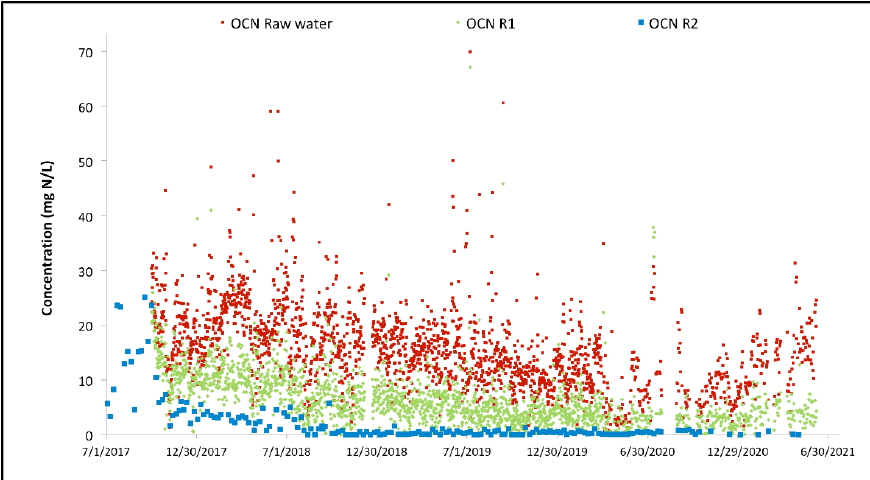
Figure 7. Total nitrogen treated load and water temperature variation in the two-stage MBBR pro- cess, along with the final ammonia concentration from the second MBBR stage.